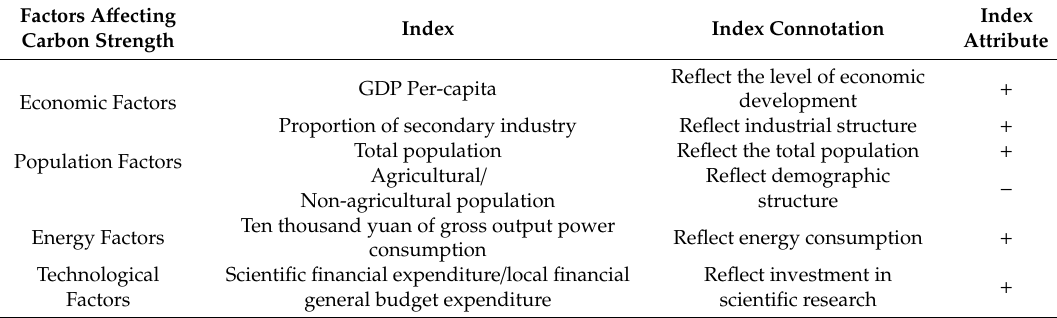
Table 2. Carbon intensity reduction target allocation index